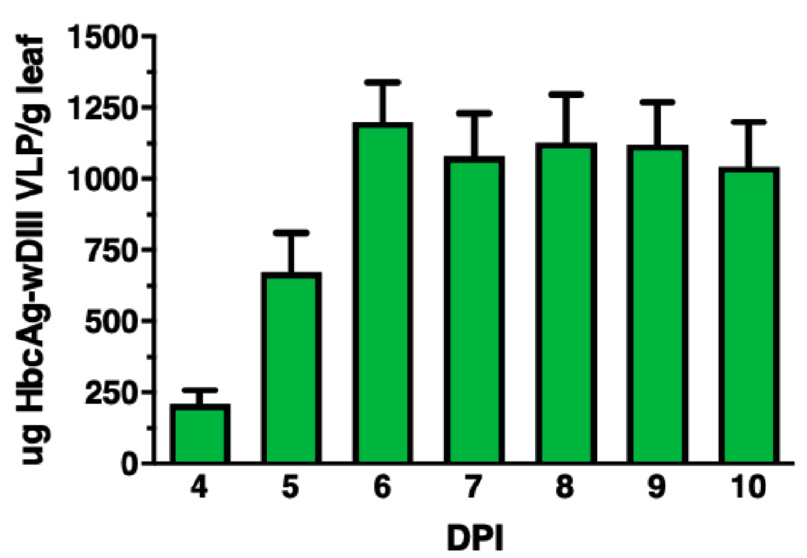
Figure 1. Temporal expression patterns of HBcAg-wDIII plant leaves. Total protein from N. ben- thamiana leaves infiltrated with HBcAg-wDIII construct was extracted on 4–10 DPI and analyzed by an ELISA with the E16 mAb, which recognizes a conformational epitope on wDIII as the capture antibody, and detected with a polyclonal anti-wDIII antibody. The means ± SD of samples from three independent experiments are presented.